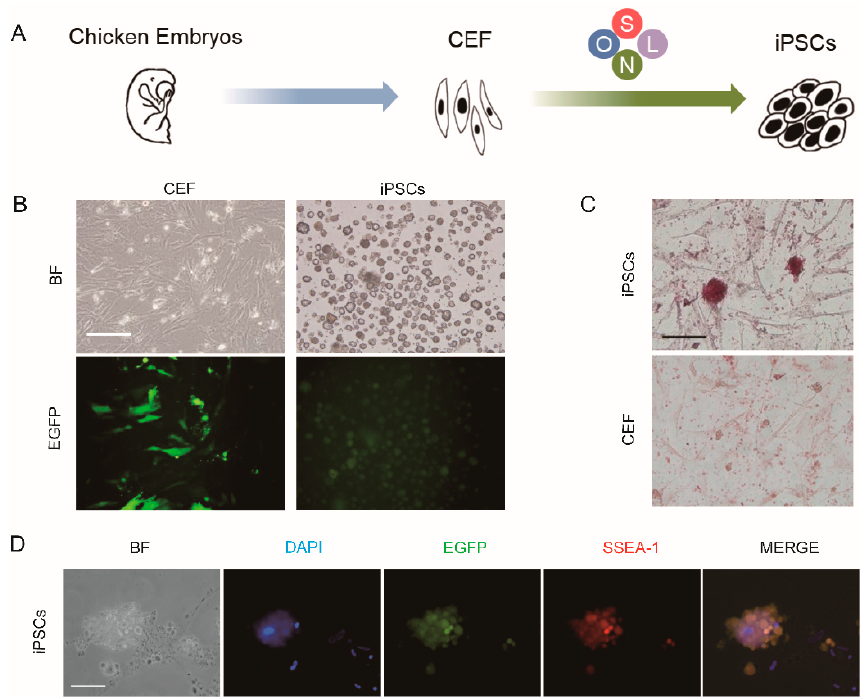
Figure 1. Generation of chicken iPSCs from chicken embryonic fibroblast (CEF) cultures via OSNL (Oct4, Sox2, Nanog, Lin28) induction strategy. ( A ) The strategy of inducing chicken iPSCs from CEF cultures. ( B ) Cell morphology and GFP expression of CEF (taken on the 3rd day of induction of reprogramming) and iPSCs (taken on the 15th day of induction of reprogramming). Scale bars = 100 µm. ( C ) Chicken iPSC clones were stained with an alkaline phosphatase kit. Scale bars = 50 µm. ( D ) Chicken iPSC clones were stained with a mouse monoclonal antibody against SSEA-1. Scale bars = 50 µm.